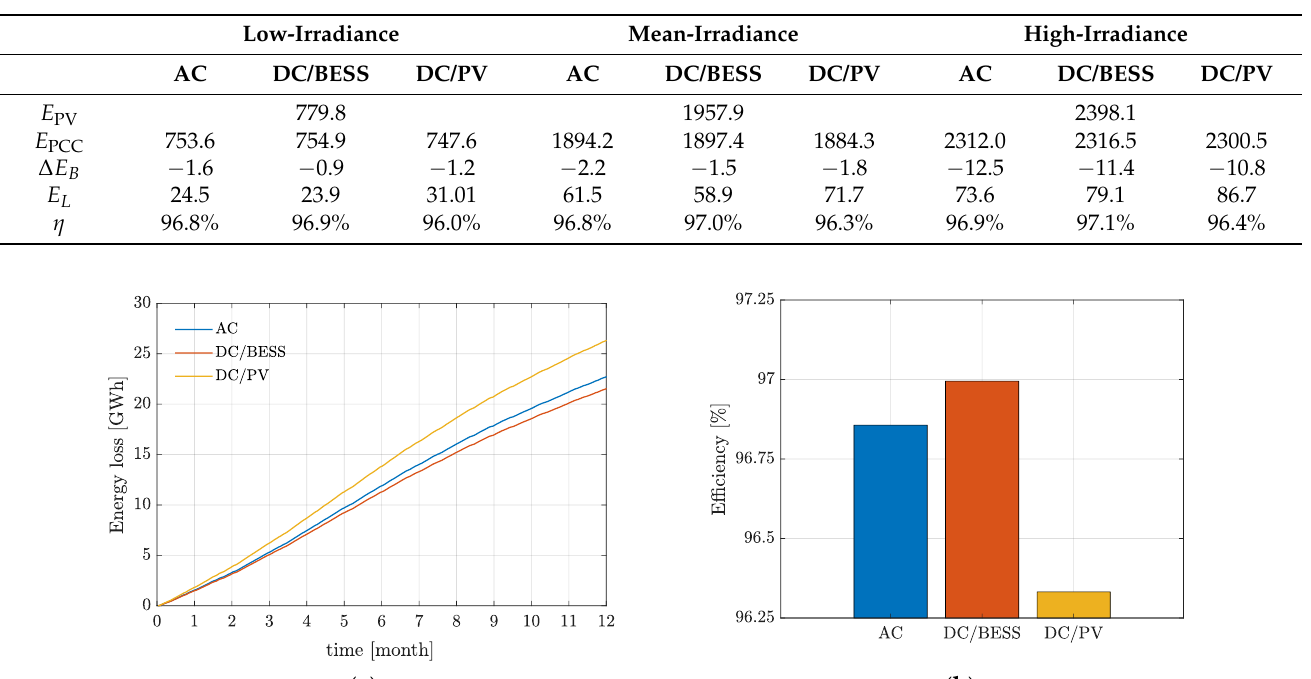
Table 3. Energy values (MWh) refer to the system’s elements. The results consider three different initial PV conditions: low, mean, and high irradiance.